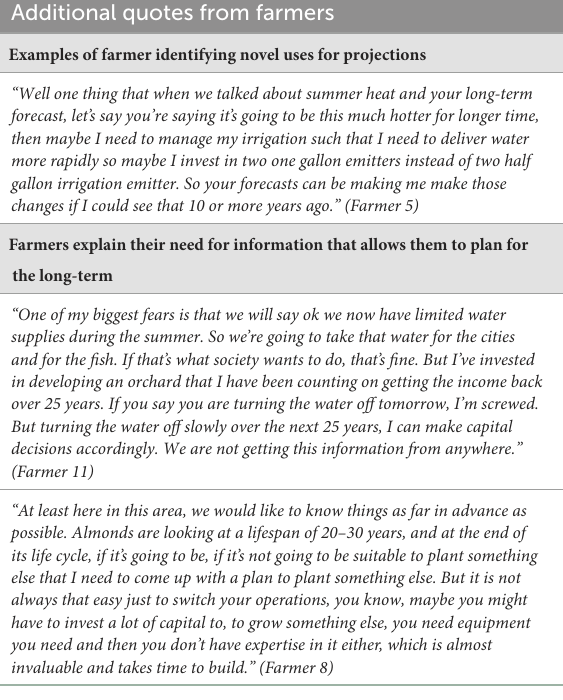
TABLE 4 Additional quotes from farmers that exemplify how they identified novel uses for projections (despite uncertainties), and their need for information that allows to plan for the